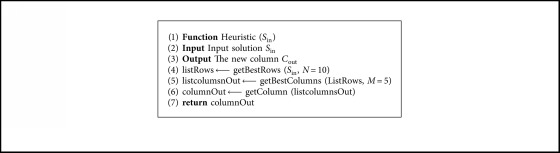
 Heuristic operator.